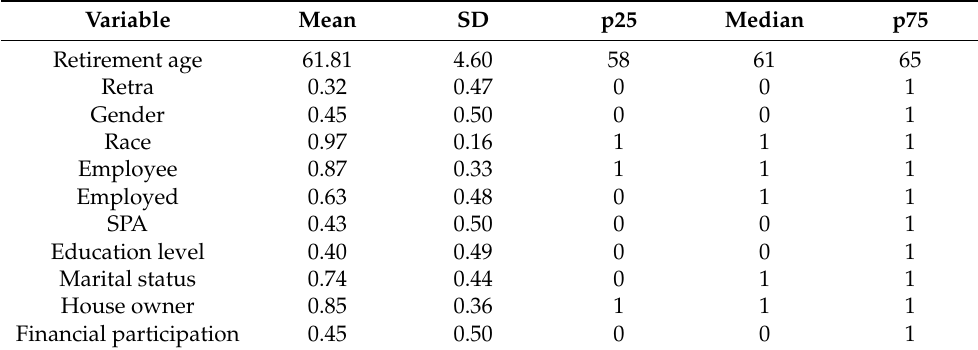
Table 1. Main descriptive statistics of the